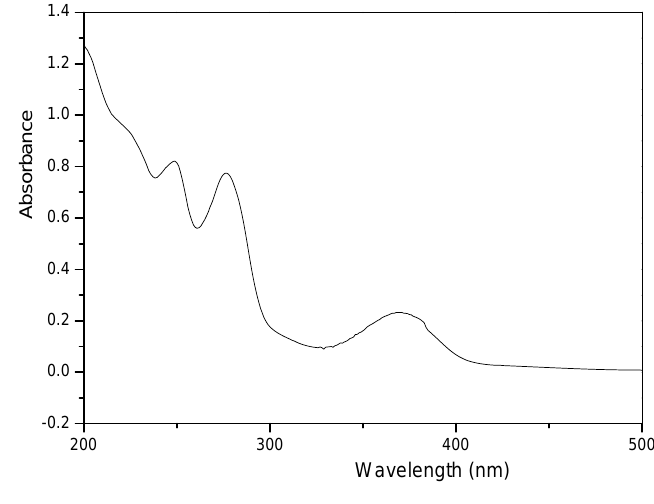
Fig.4S UV spectrum of